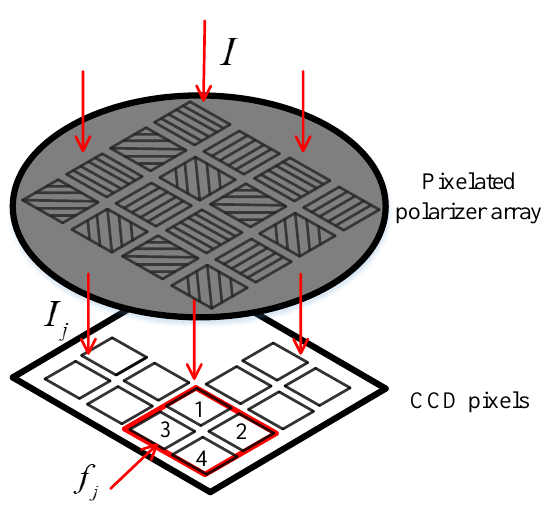
Figure 4. Schematic representation of the response of CCD